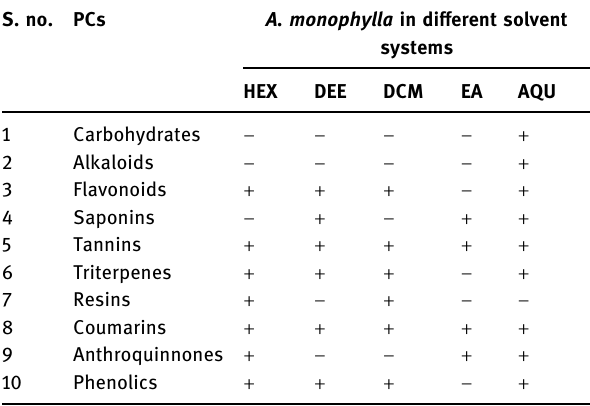
Table A1: Qualitative analysis of phytochemical screening